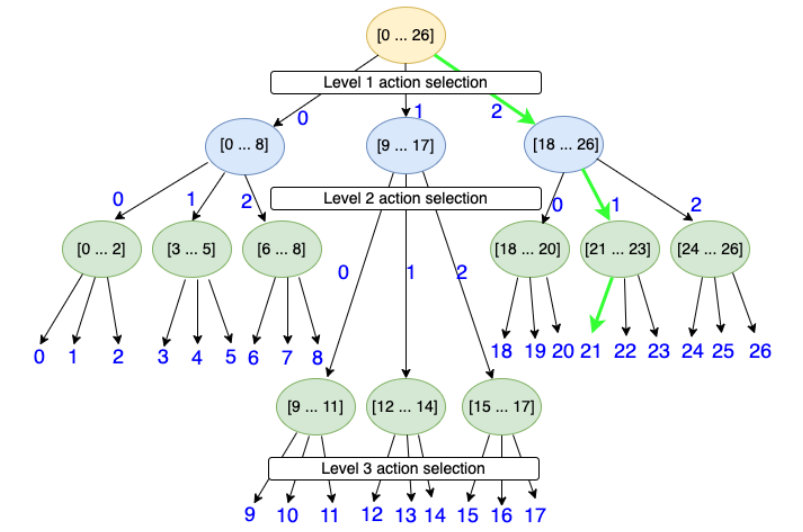
Figure 2. An illustration of a tree-based structure for hierarchical action selection. The primitive action identifiers are located on the leaf nodes. Each internal node contains the action range of its children.